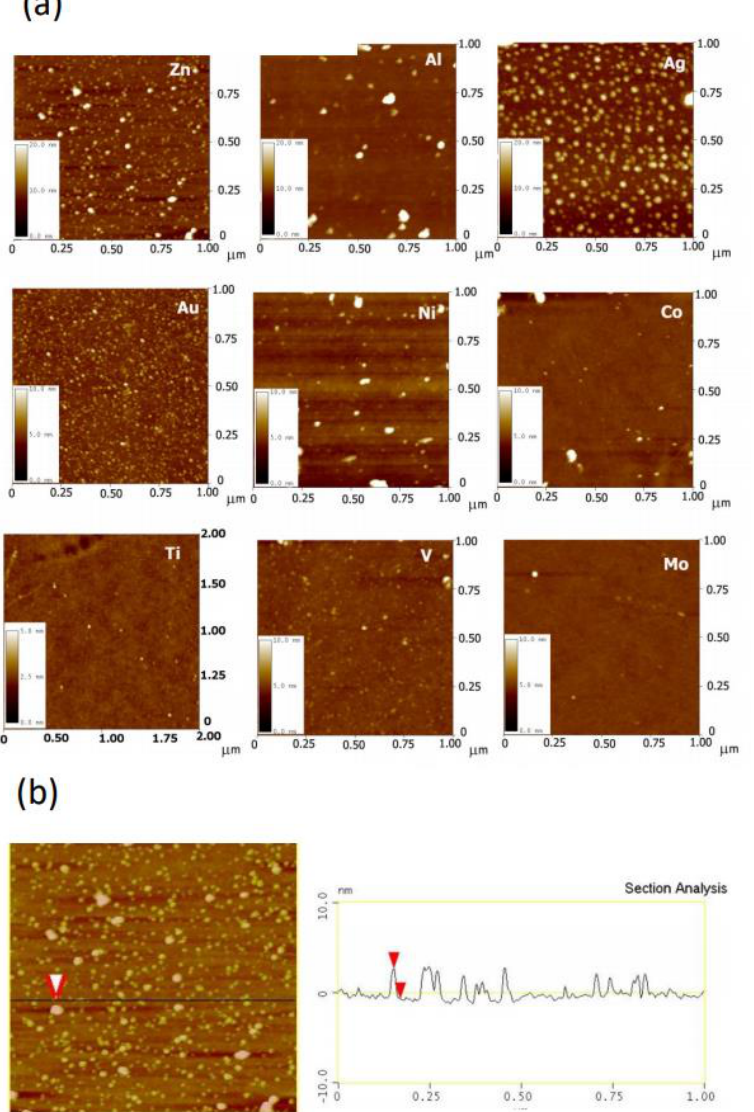
Figure 2. ( a ) Atomic force microscope (AFM) images of various metal nanoparticles prepared by